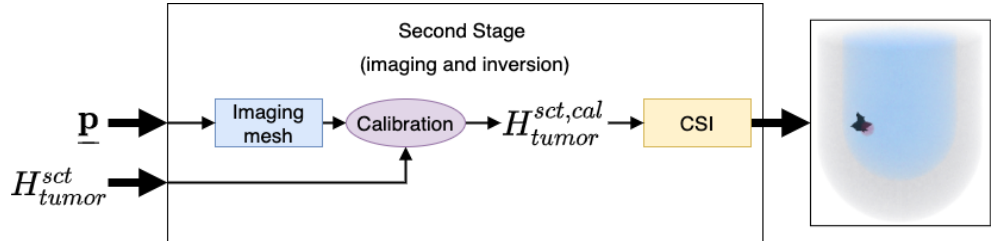
Figure 5. Workflow stage 2 employing CSI, where p is obtained from the bulk parameter inference network (first stage), and specifies the fibroglandular region in the imaging mesh. Contrast Source